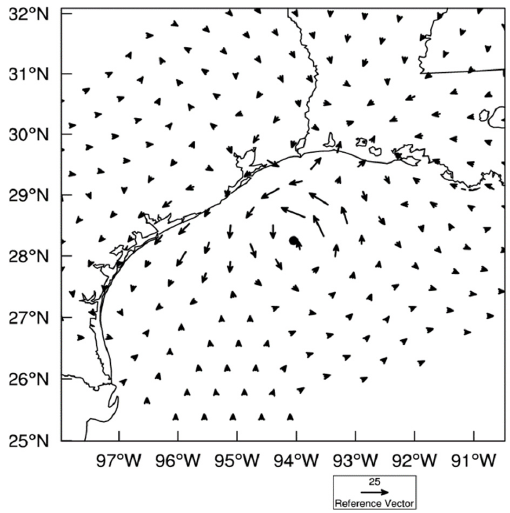
Figure 5. The 700 hPa wind analysis increments (m/s) at 0000 UTC 13 Sep 2008 from experiment DA_Radar.